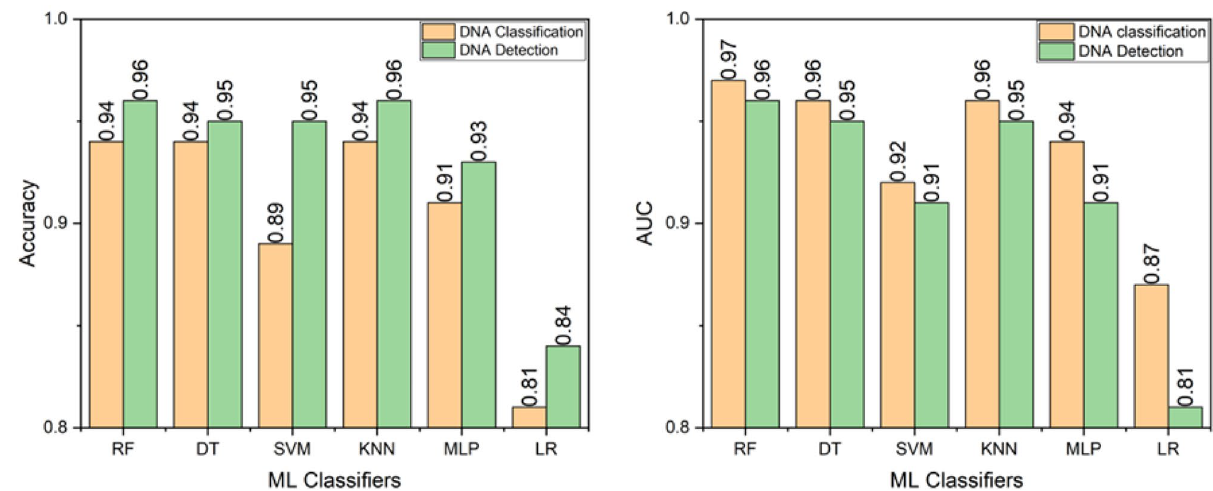
Figure 7. Accuracy (left) and AUC scores (right) of different classifiers and